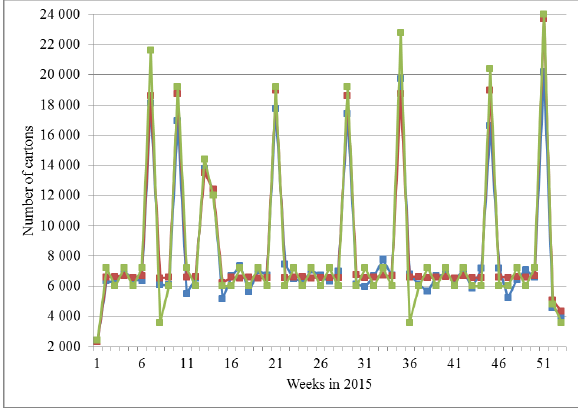
Figure 2: Annual demand (number of cartons) of customers, stores and warehouse in 2015.